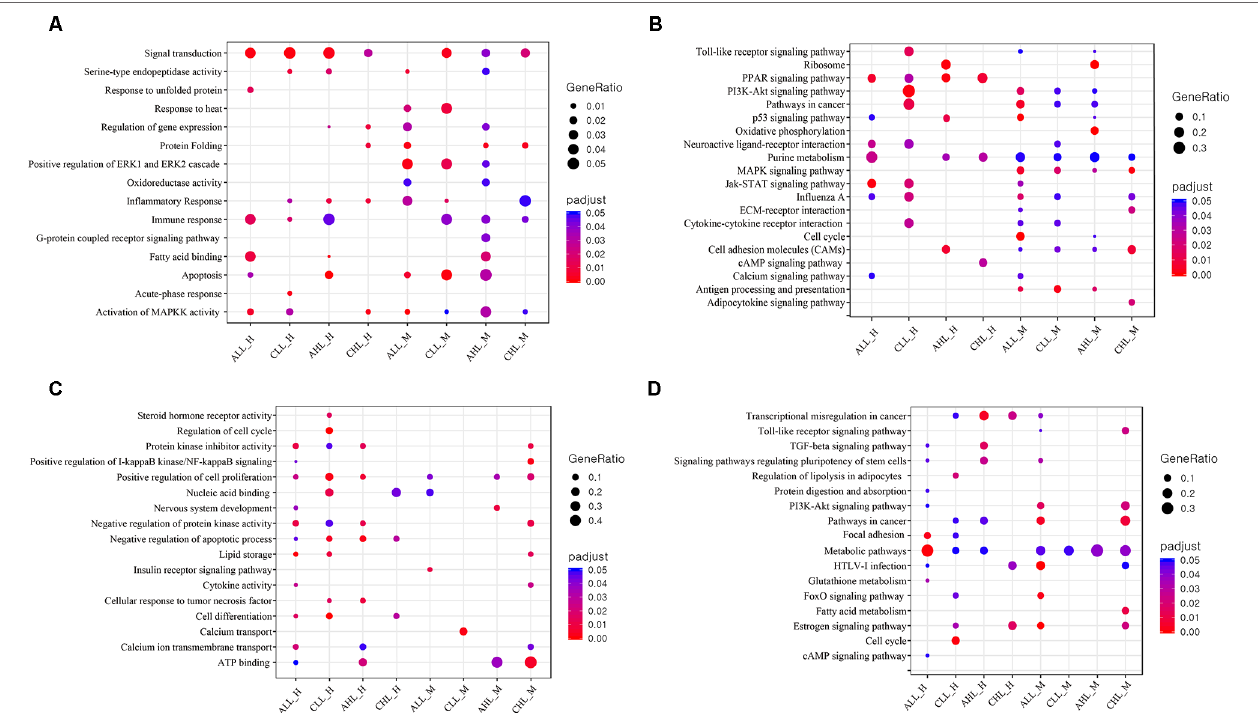
FIGURE 4 | GO and KEGG pathway enrichment analysis (A) Dot plot shows the up-regulated GO terms (FDR <0.05) of biological processes and molecular functions identified using DAVID to be enriched under the different contrasts. (B) Dot plot shows the up-regulated KEGG pathways (FDR <0.1) enriched for different contrasts. The size of the dot is based on gene count enriched in the pathway, and the color of the dot shows the pathway enrichment significance. (C) Dot plot shows the down-regulated GO terms (FDR <0.05) of biological processes and molecular functions identified using DAVID to be enriched under the different contrasts. (D) Dot plot shows the down-regulated KEGG pathways (FDR <0.1) enriched for different contrasts. The size of the dot is based on gene count enriched in the pathway, and the color of the dot shows the pathway enrichment